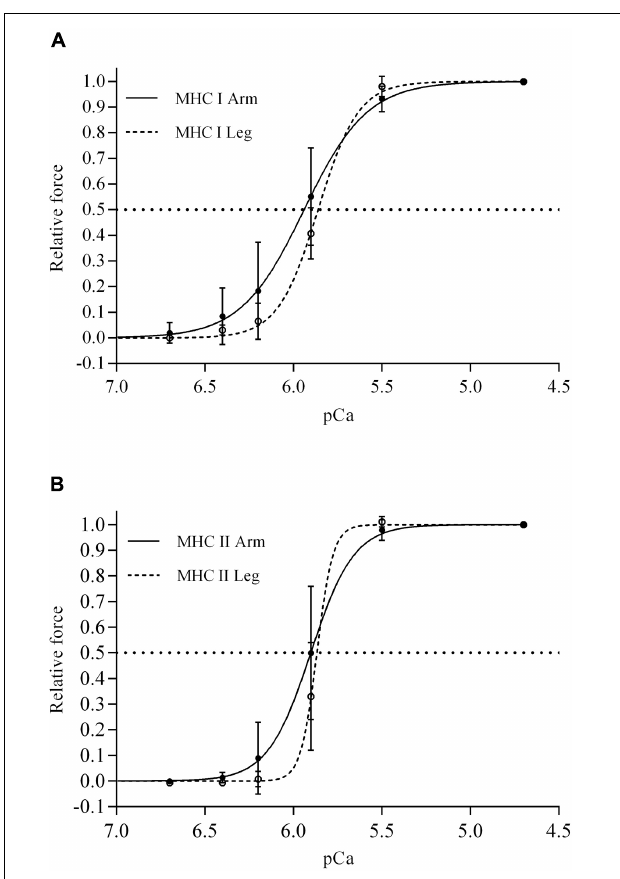
FIGURE 2 | The mean force–Ca 2 + relationship for single MHC I (A) and MHC II fibers (B) isolated from m. triceps brachii (continuous lines) and m. vastus lateralis (discontinuous lines) of eight highly trained cross-country skiers. The horizontal lines indicate pCa 50 (i.e., 50% of maximal force), the dots are the mean relative force generation at different [Ca 2 + ] and the associated vertical lines standard deviations. There were significant MHC × limb interactions for both Ca 2 + sensitivity ( P = 0.04), force generation at pCa 5.9 ( P = 0.003), and the Hill coefficient ( P < 0.0001). Exact values of pCa 50 and the slope of the curves (i.e., Hill coefficient) are documented in Table 1